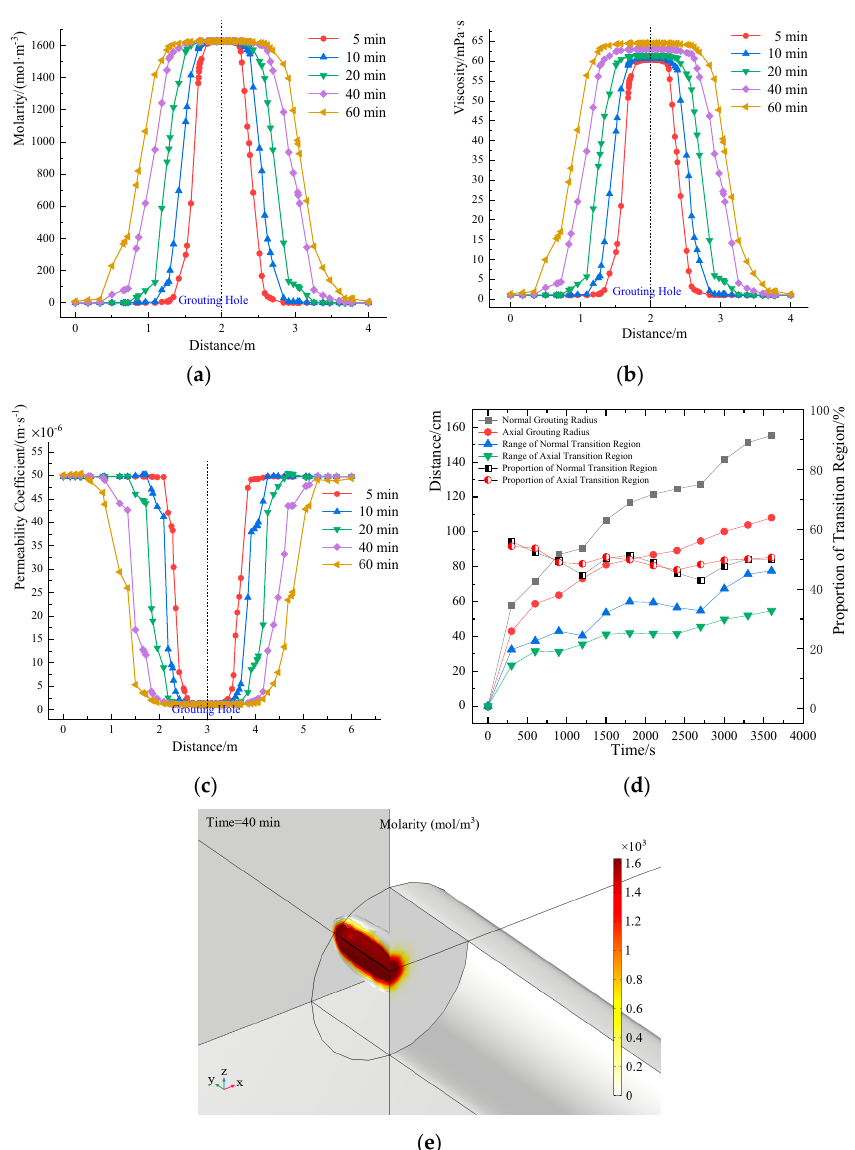
Figure 4. Basic law of grouting migration (initial permeability 5D, grouting pressure 2 MPa, and water–cement ratio 1.0). Panel ( a ) displays the molarity distribution characteristics of grouting materials at different times; ( b ) displays the viscosity distribution characteristics of grouting materials at different times; ( c ) displays the permeability coefficient distribution characteristics of grouting materials at different times; ( d ) displays the grouting radius and range of transition region of grouting materials at different times; ( e ) displays the molarity contour surface of grouting material migration for 40 min.